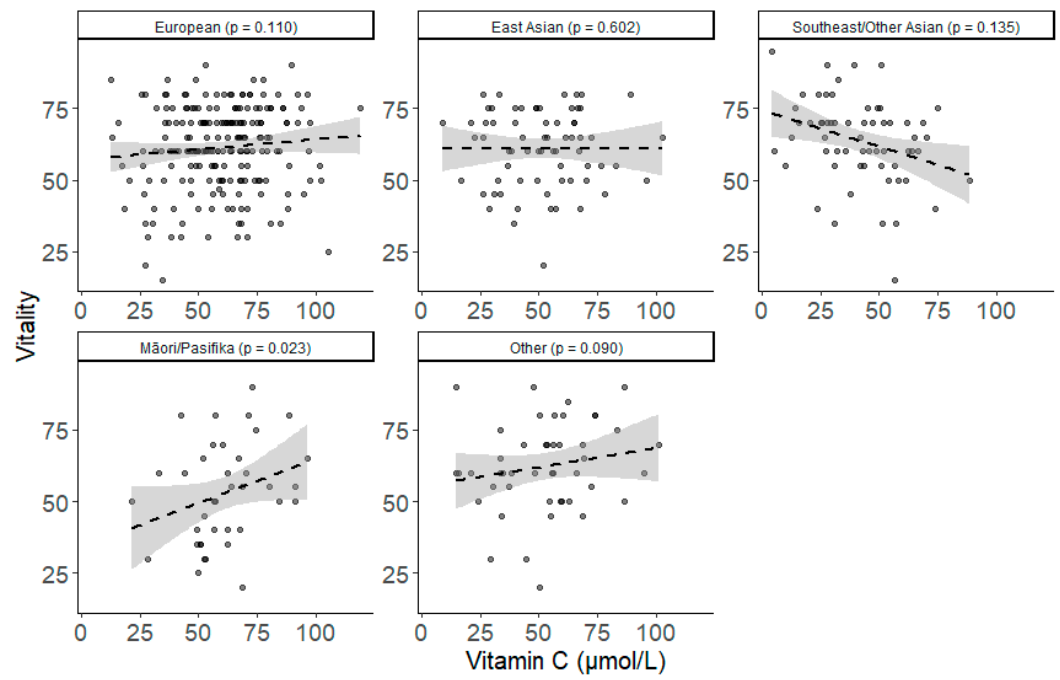
Figure 5. Simple scatterplots of the unadjusted relationship between vitamin C and vitality between different ethnic groups (Europeans, East Asians, Southeast/Other Asians, M ā ori/Pasifika and Other). Dashed line indicates the line of best fit. Grey shading indicates 95% confidence intervals. p values for fully adjusted simple slopes. Nutrients 2021 , 13 , x FOR PEER REVIEW